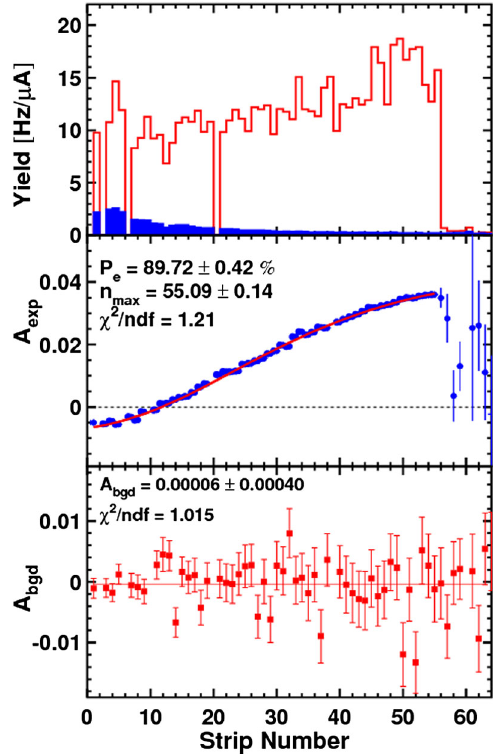
FIG. 3. Yield and asymmetry data from a single detector plane plotted versus detector strip number, for a typical hour-long run. Statistical uncertainties only. (Top panel) The charge normalized yield at a beam current of 180 μ A and laser intensity of 1.7 kW. The laser-on yield is shown in red, and the laser-off (background) yield is shown in shaded blue. (Middle panel) The measured Compton asymmetry (background-subtracted). The solid red line is a fit to Eq. (2). (Bottom panel) The background asymmetry from the laser-off period. The solid red line is a fit to a constant